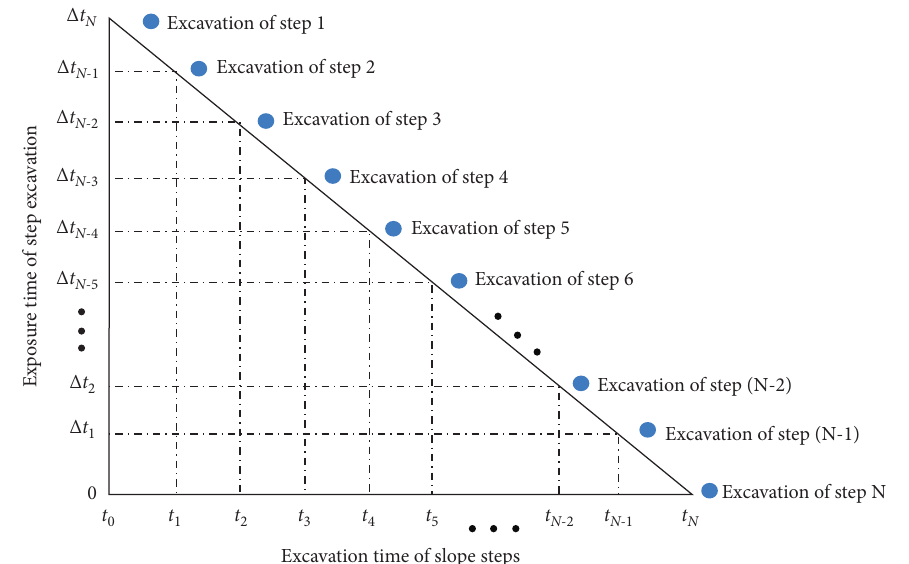
Figure 9: Relationship between slope excavation and rock exposure cumulative